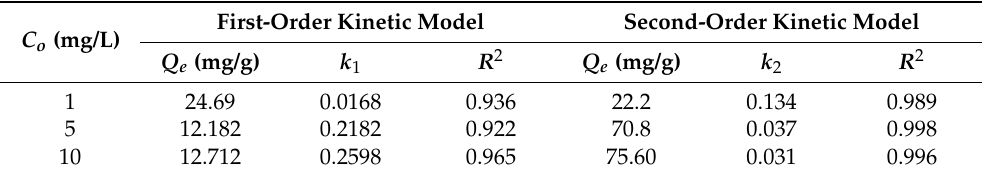
Figure 12. ( a ) The pseudo-first-order and ( b ) pseudo-second-order kinetics for the adsorption of lead ions by PPy-PEI Nano adsorbent Pb 2+ . Table 7. Calculated kinetic parameters of the PFO and PSO kinetic for lead ion on polypyrrole- polyethhyleneimine Nano adsorbent at pH 10 and 50 ◦